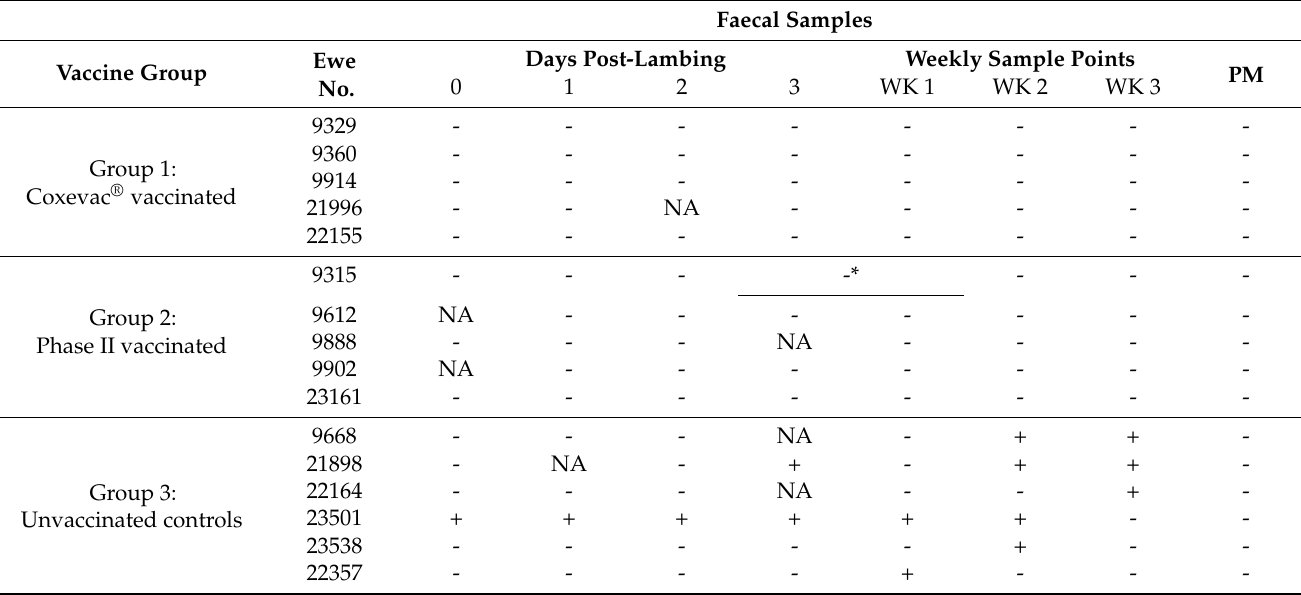
Table 4. Presence (+) or absence (-) of C. burnetii DNA in faecal samples. Samples were collected on day of lambing (0) and then for three consecutive days (1, 2 and 3). Samples were then collected weekly for 3 weeks, with a final sample set collected immediately prior to post-mortem (PM). Faecal Samples Days No.